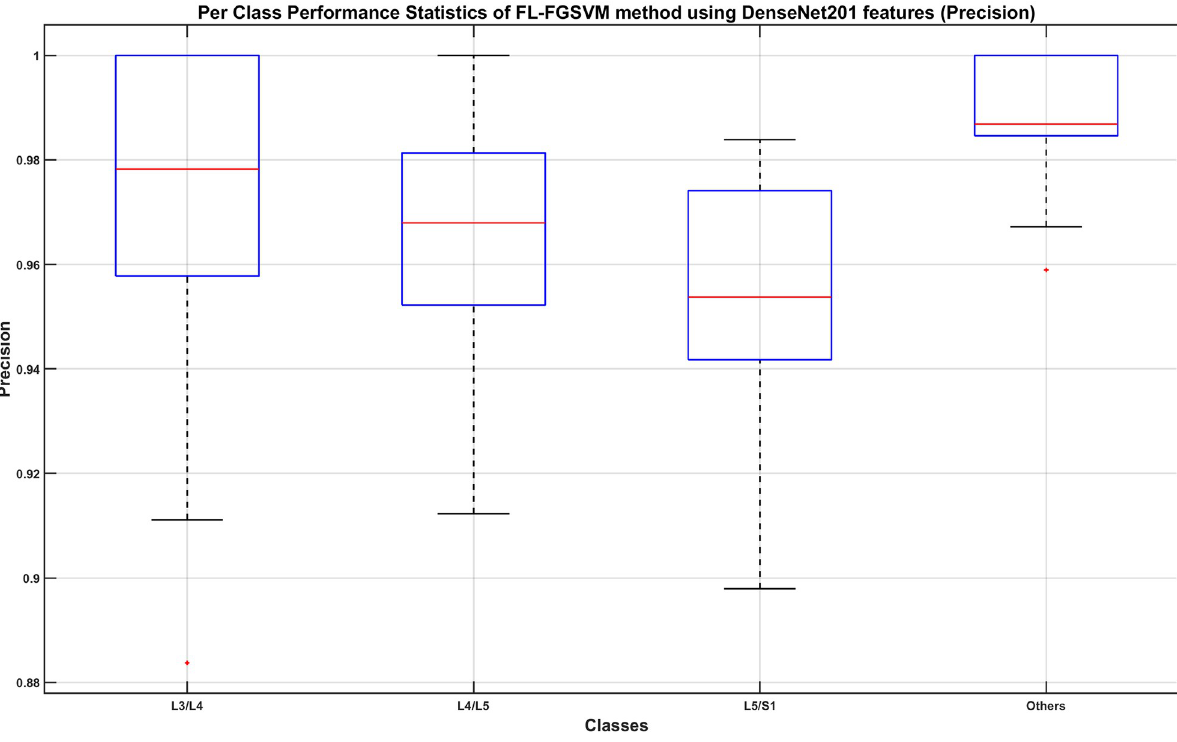
Fig 12. Per-class classification performance using Fine Gaussian SVM classifier on full-length DenseNet201 features (Precision).